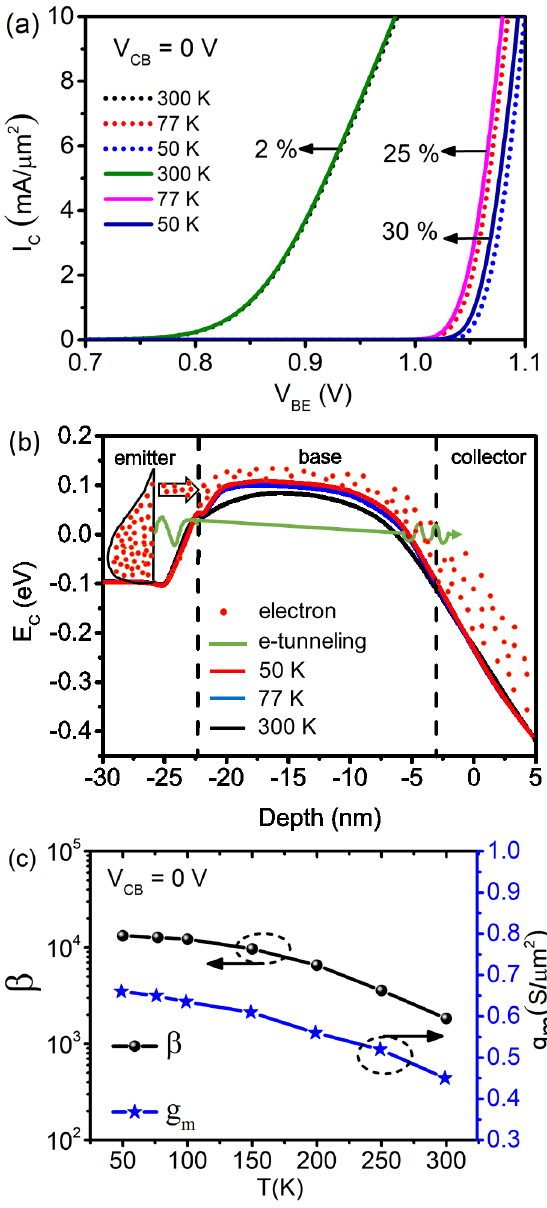
Figure 6. ( a ) I C —V BE characteristics with (solid line) and without (dotted line) barrier tunneling leakage; ( b ) conduction band edge energy ( E C ) versus depth for the intrinsic HBT, the theoretical prediction of e − barrier tunneling from the BE junction into the base contributing to collector current leakage; and ( c ) DC gain ( β ) and transconductance ( g m ) versus temperature (T).